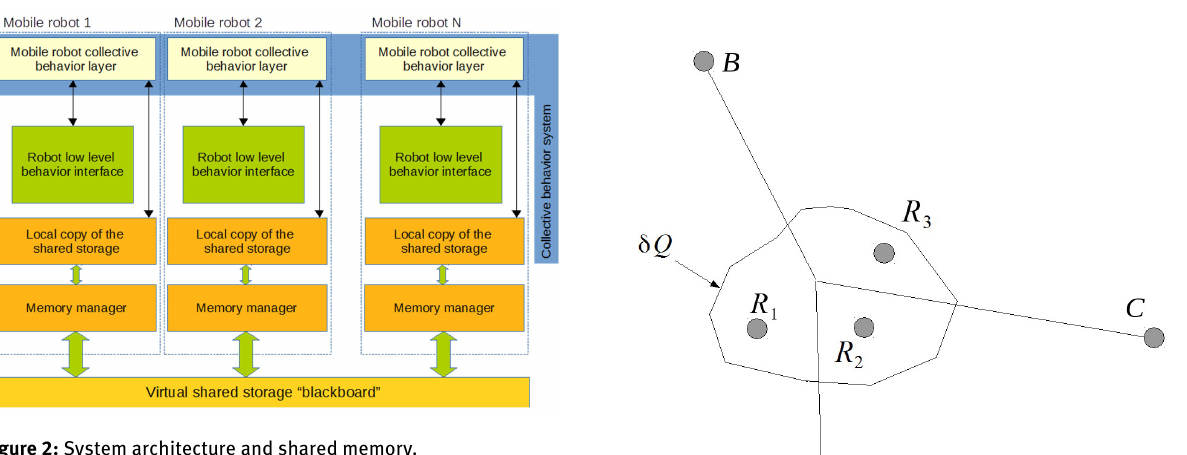
Figure 2: System architecture and shared memory.